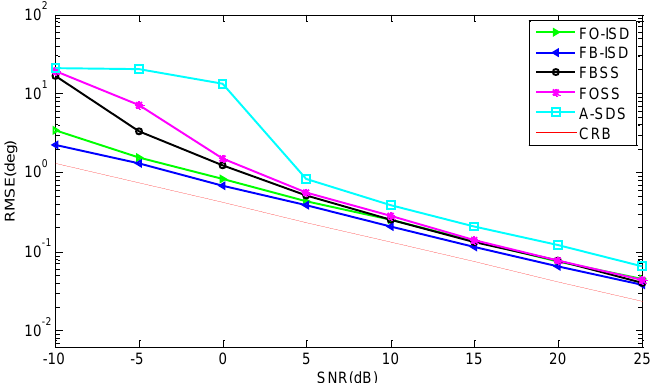
-10 Figure 6. RMSE curves versus the SNR in the white noise condition.